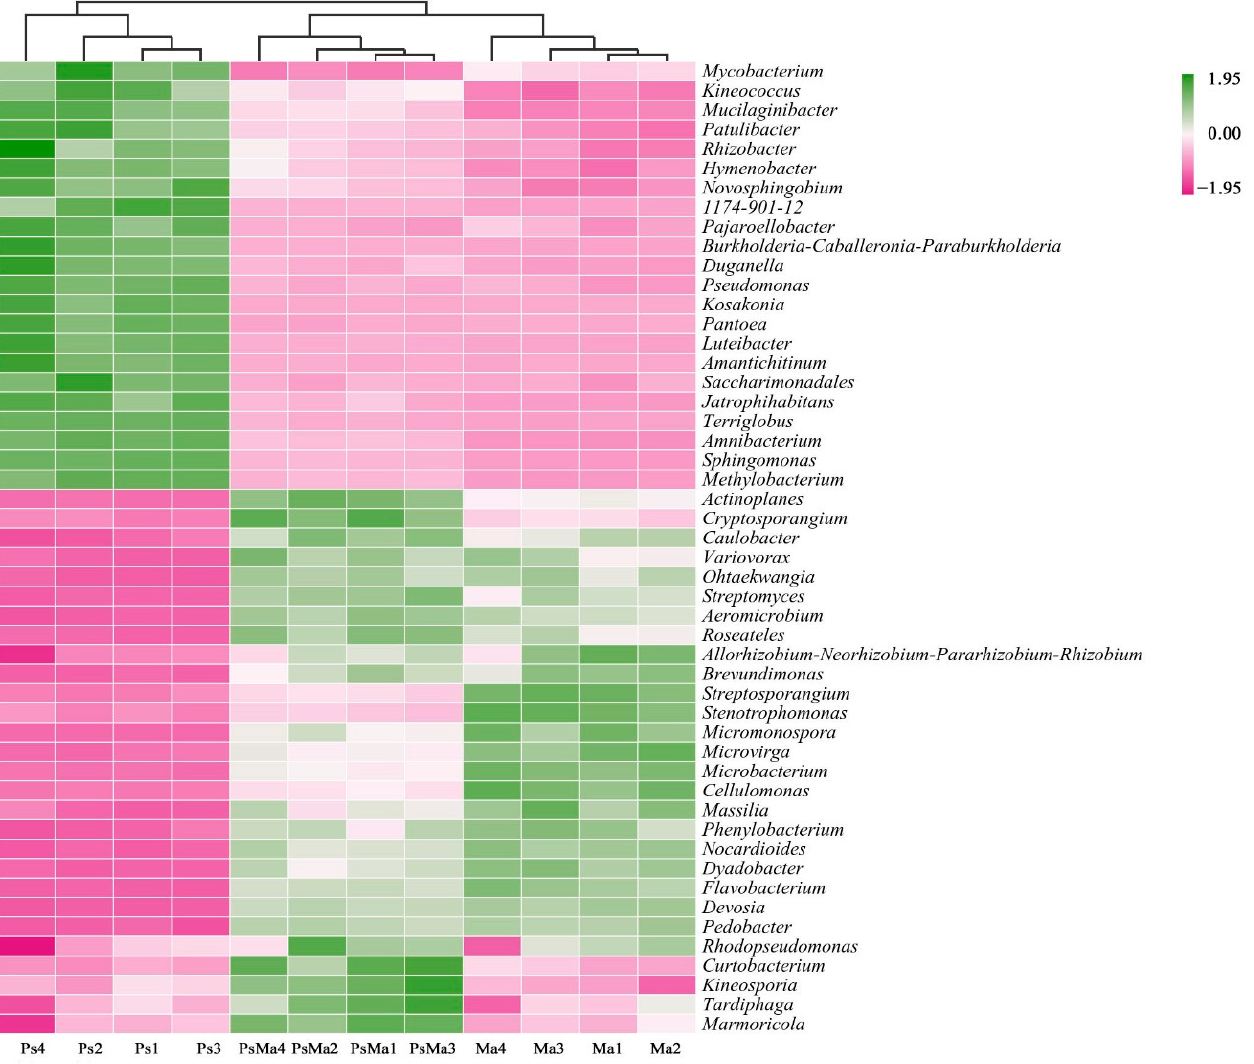
Figure 7. Heatmap and cluster analysis based on relative abundance of the top 50 genera identified in litter bacterial communities. The samples are grouped according to their similarity to each other. In the figure, pink represents the genus with lower abundance in the corresponding sample, green represents the genus with higher abundance, and the color change represents the level of abundance. Ma: Morus alba ; PsMa: Pinus sylvestris var. mongolica × Morus alba ; Ps: Pinus sylvestris var. mongolica .